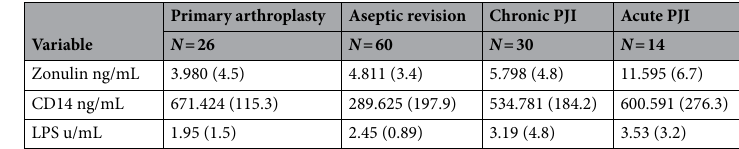
Table 2. Plasma gut permeability markers based on arm allocation. Data was presented as mean and standard deviation. PJI: periprosthetic joint infection. PJI definition was based on 2018 international consensus meeting definition.